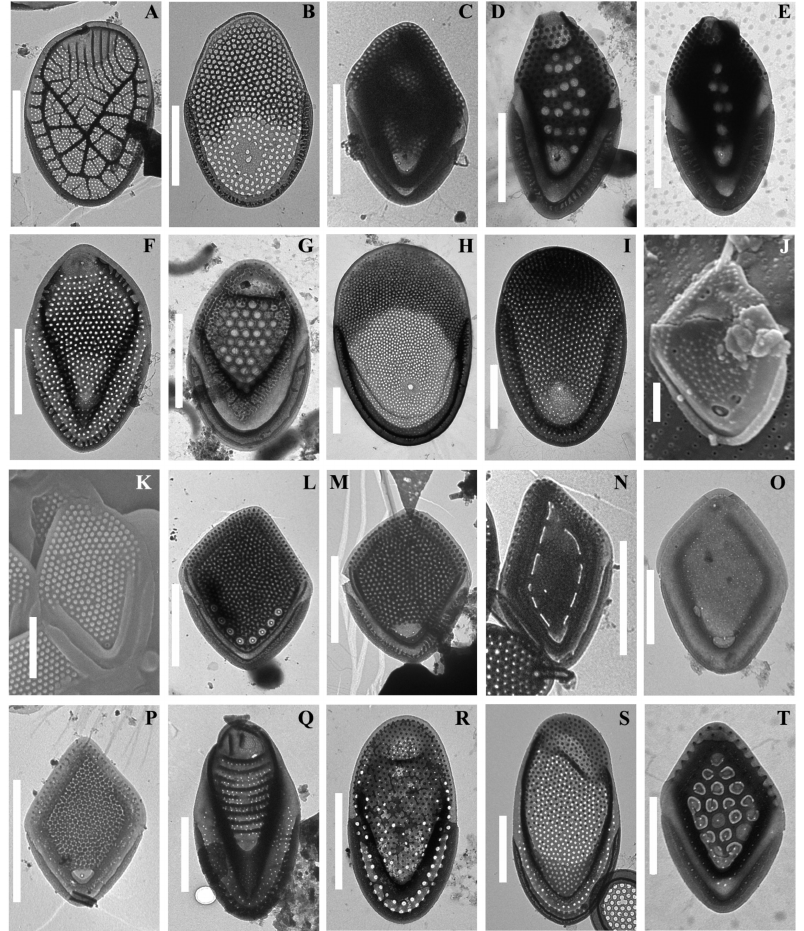
Figure 3. Scales of Mallomonas . ( A ) M. harrisiae . ( B ) M. hexareticulata . ( C ) M. grata . ( D ) M. guttata var. guttata . ( E ) M. guttata var. simplex . ( F ) M. kenyana . ( G ) M. korshikovii . ( H ) M. lamii . ( I ) M. loricata